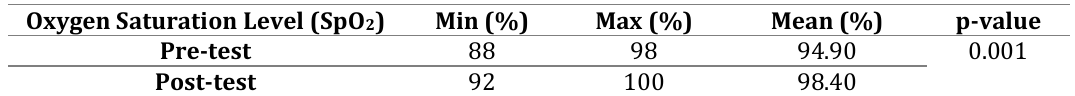
Table 2 Oxygen Saturation Level Before and After Prone Positioning Implementation (n=30) Oxygen Saturation Level (SpO 2